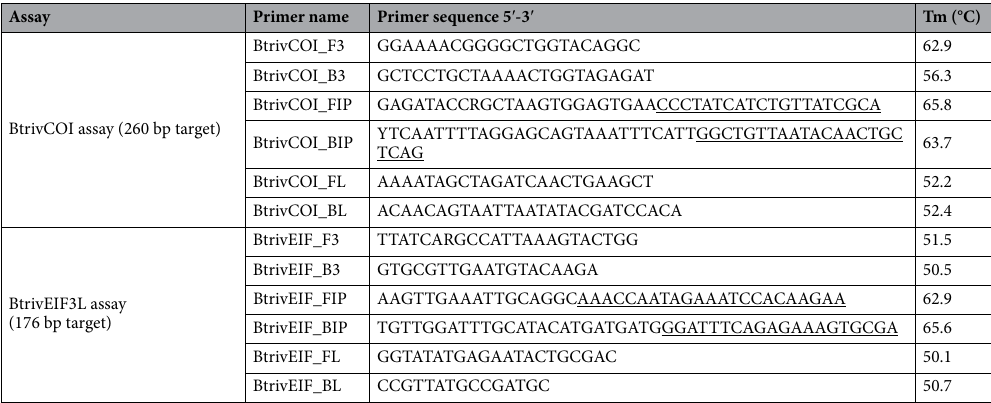
Table 1. Sequences and Tm (°C) of primers designed in this study for BtrivCOI and BtrivEIF3L LAMP assays developed for detection of Bactrocera trivialis. The F2 and B2 primer regions of FIP and BIP are underlined.